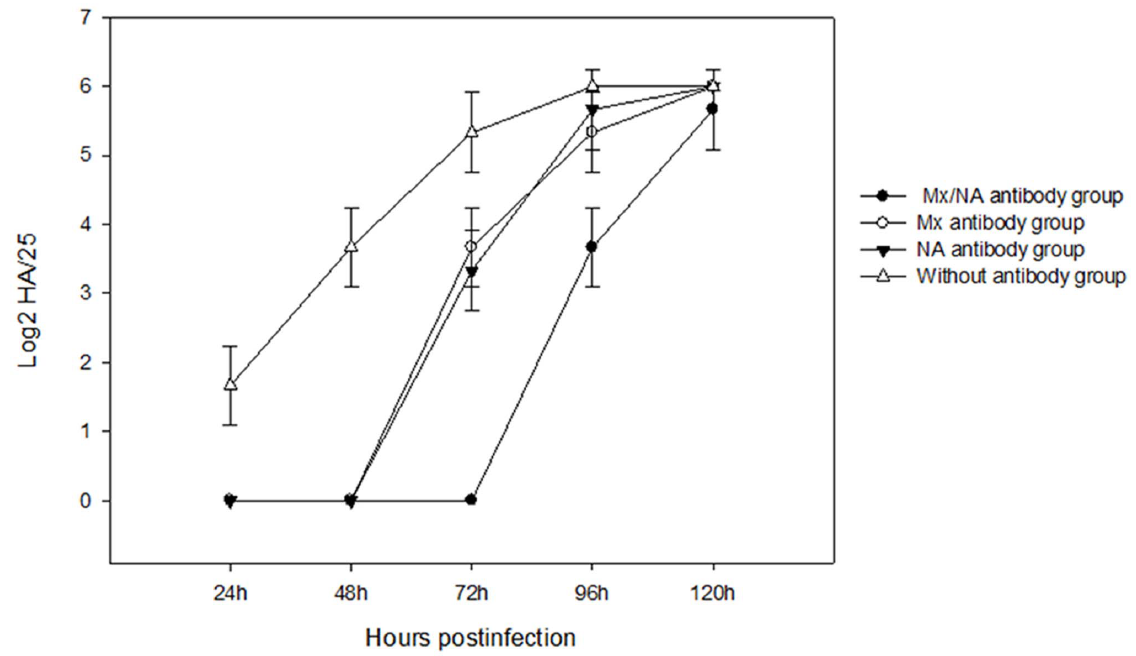
Figure 6. HA of antibody group infected NDV at different time. After G418 selection for two weeks, the antibody incubated CEF cells were trypsinized and seeded into 24-well plates. After overnight cultivation, 100 TCID50 NDV was added to each well (in triplicates) and incubation was continued for 1 h at 37 u C. After 24, 48 and 72 h infection, supernatants of the cell cultures were collected for NDV titration on CEF cells.